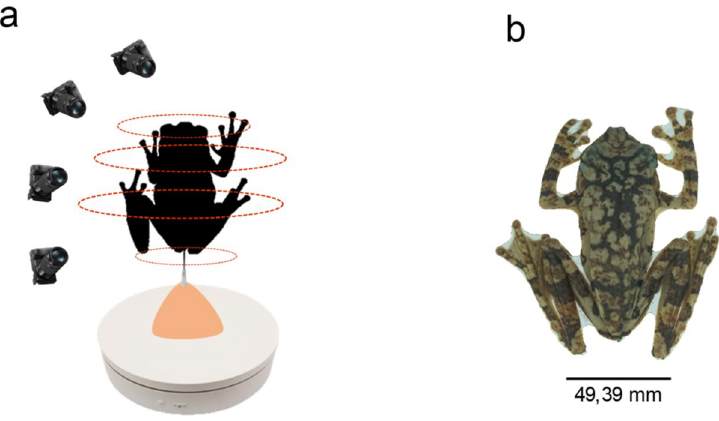
Figure 4. Reconstruction of 3D models using the photogrammetry method. ( a ) The first step is to position the samples to capture the photos from four different angles. ( b ) After the 2D image overlay step by Autodesk Recap